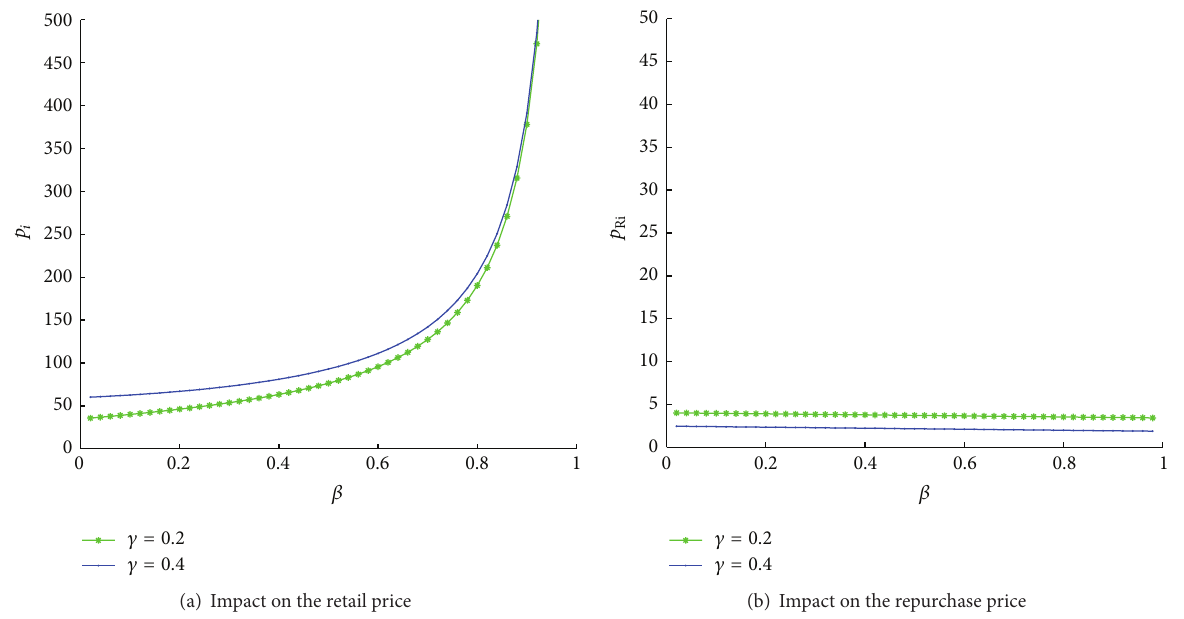
Figure 2: Impact of the retailing and recycling substitution effects on price in model 𝐶